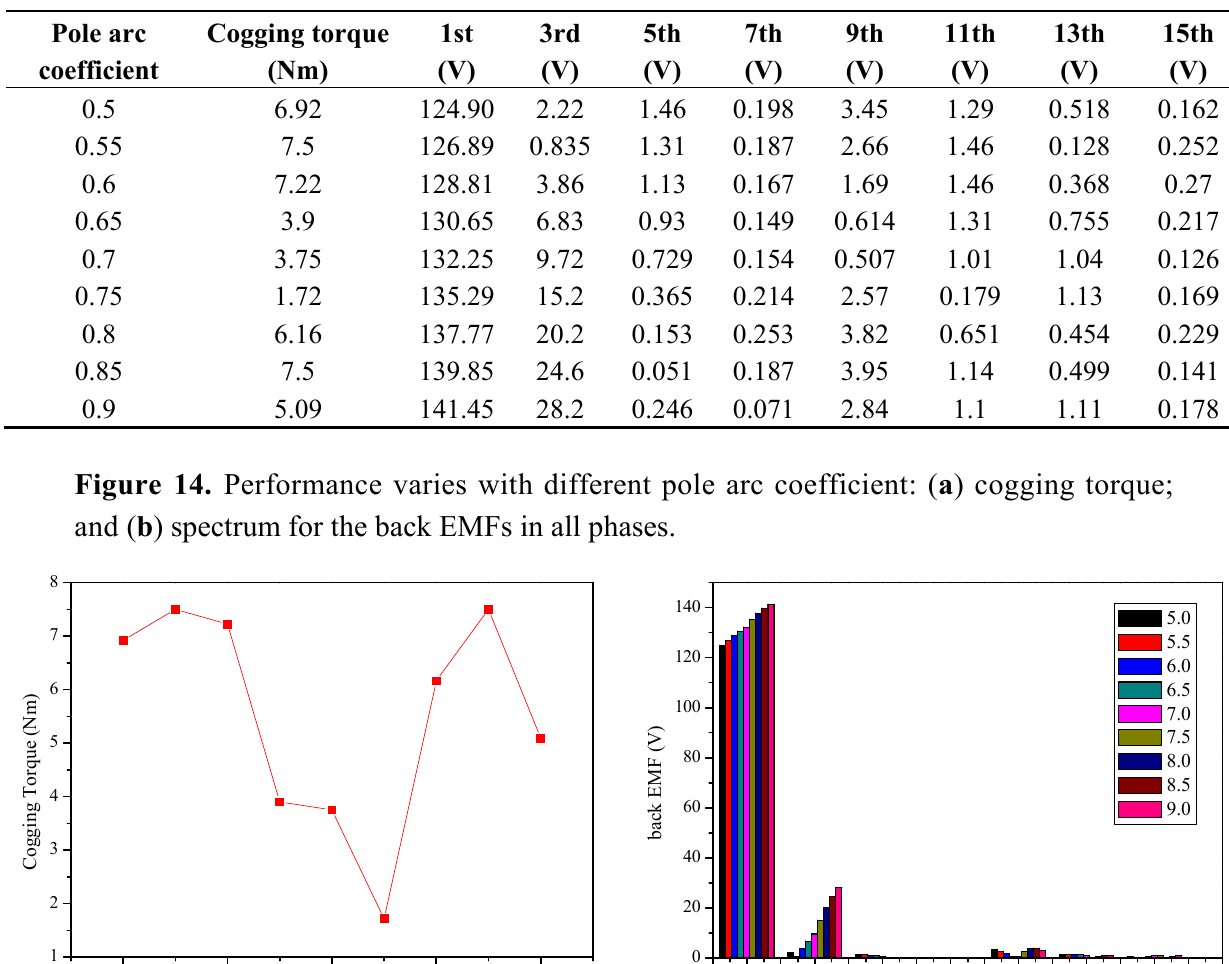
Table 6. Cogging torque and harmonic components of back EMF.